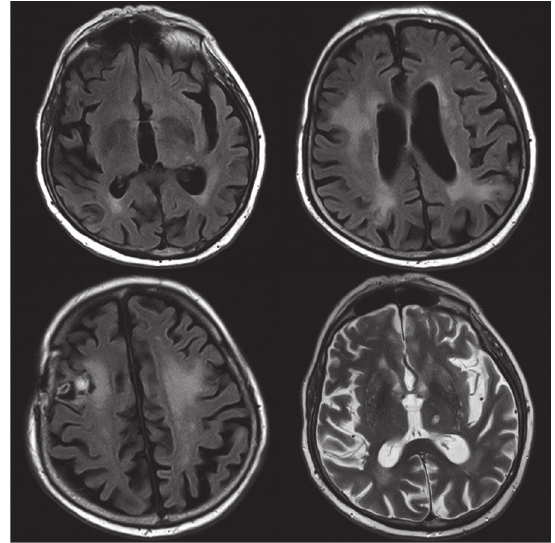
Figure 6: MRI at six-month posttherapy follow-up (day 270). Many of the areas previously demonstrating diffusion hyperintensity have improved and/or resolved. Several areas of diffusion hyperintensity remain. FLAIR hyperintensities are grossly similar except for some improvement in the left thalamic region and some worsening in the right parietal